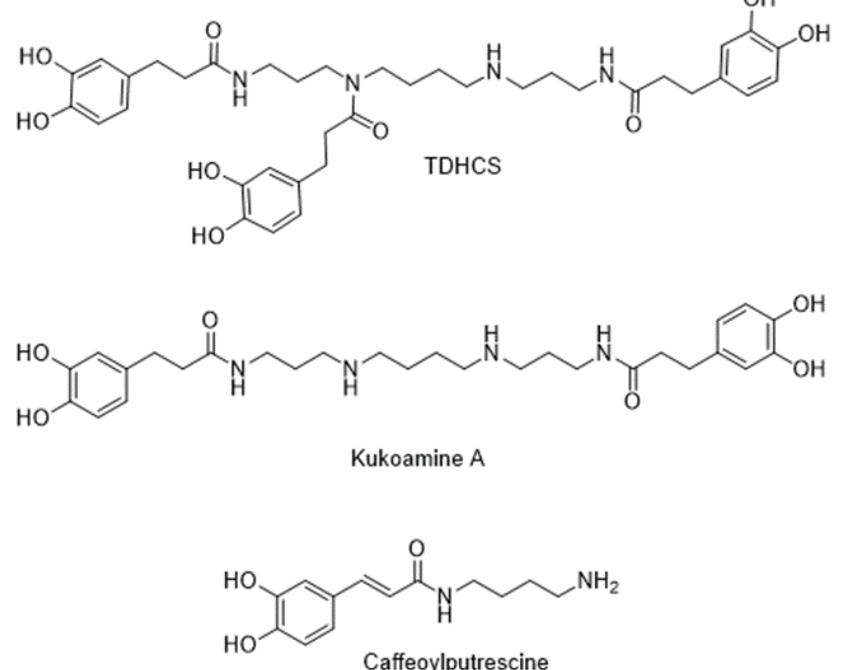
Figure 1. Chemical structure of the main phenolamides studied in this work.